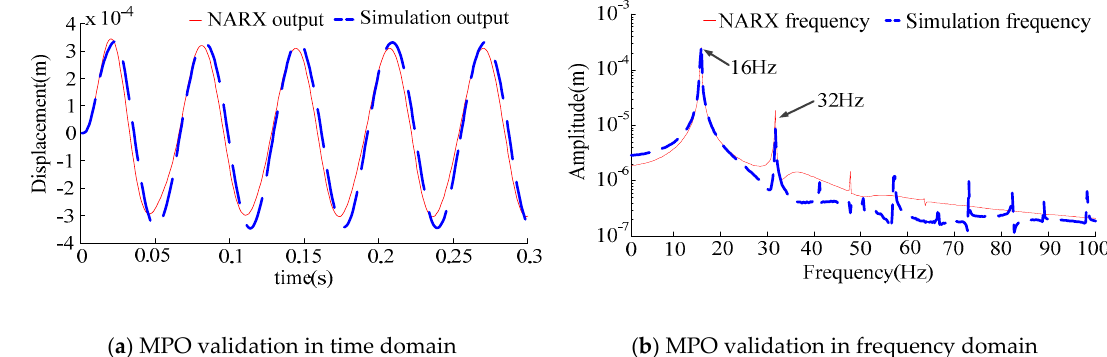
Figure 9. Output comparison in time and frequency domain at a low speed.